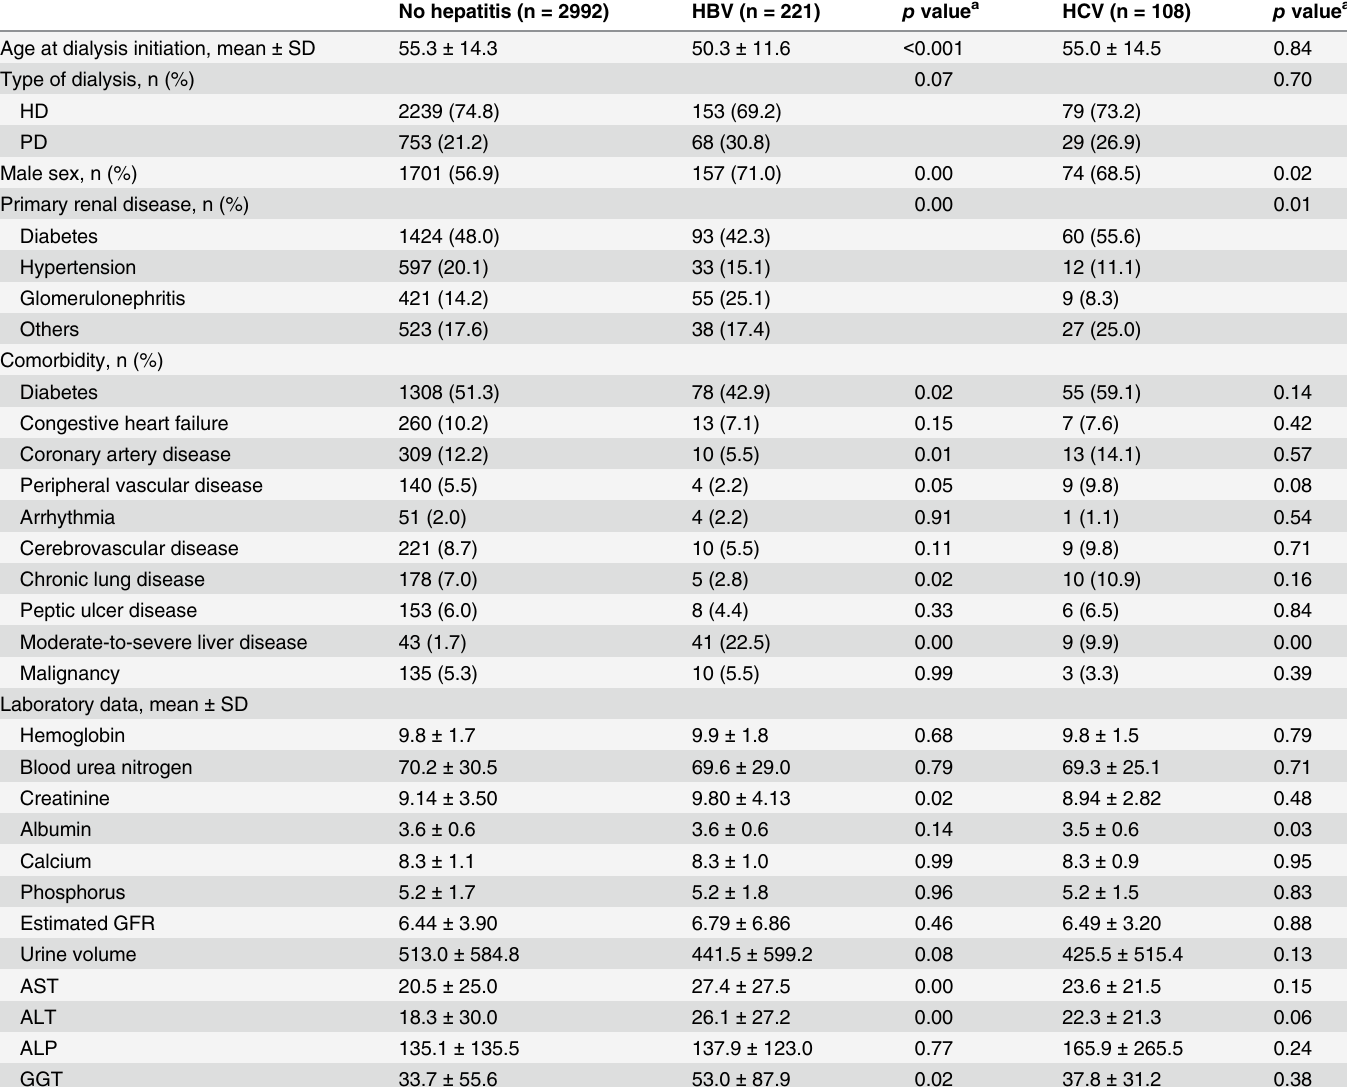
Table 1. Baseline characteristics of patients with hepatitis B, with hepatitis C, or without hepatitis infection. No hepatitis (n = 2992) HBV (n =